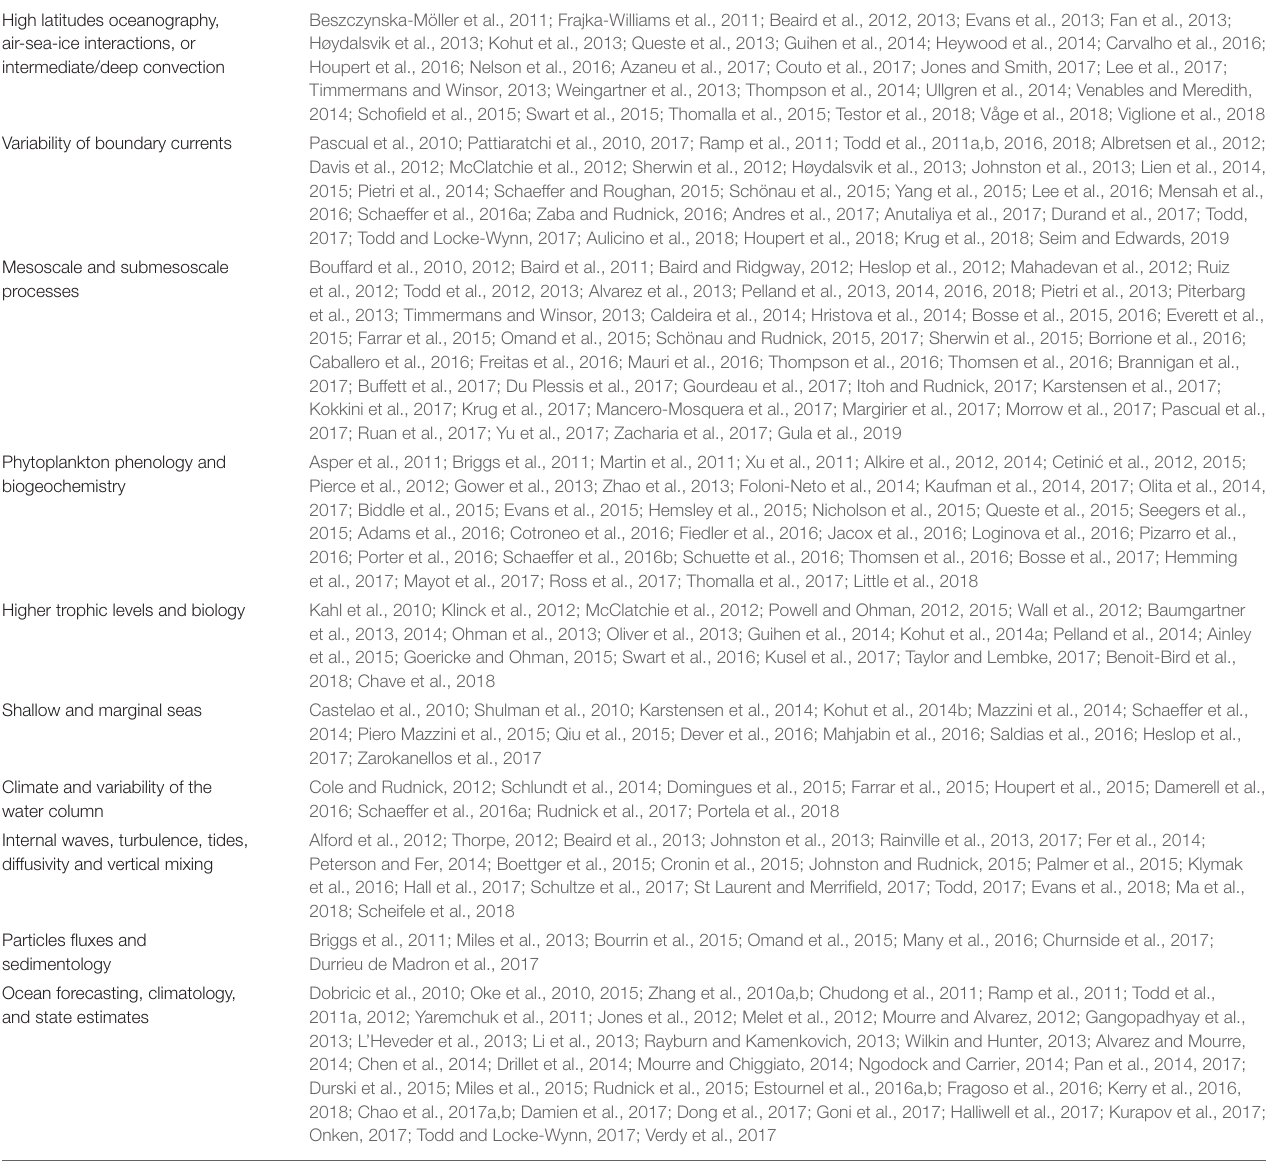
TABLE 1 | Highlights on results during the past decade using the glider technology. High latitudes oceanography, air-sea-ice interactions, or intermediate/deep